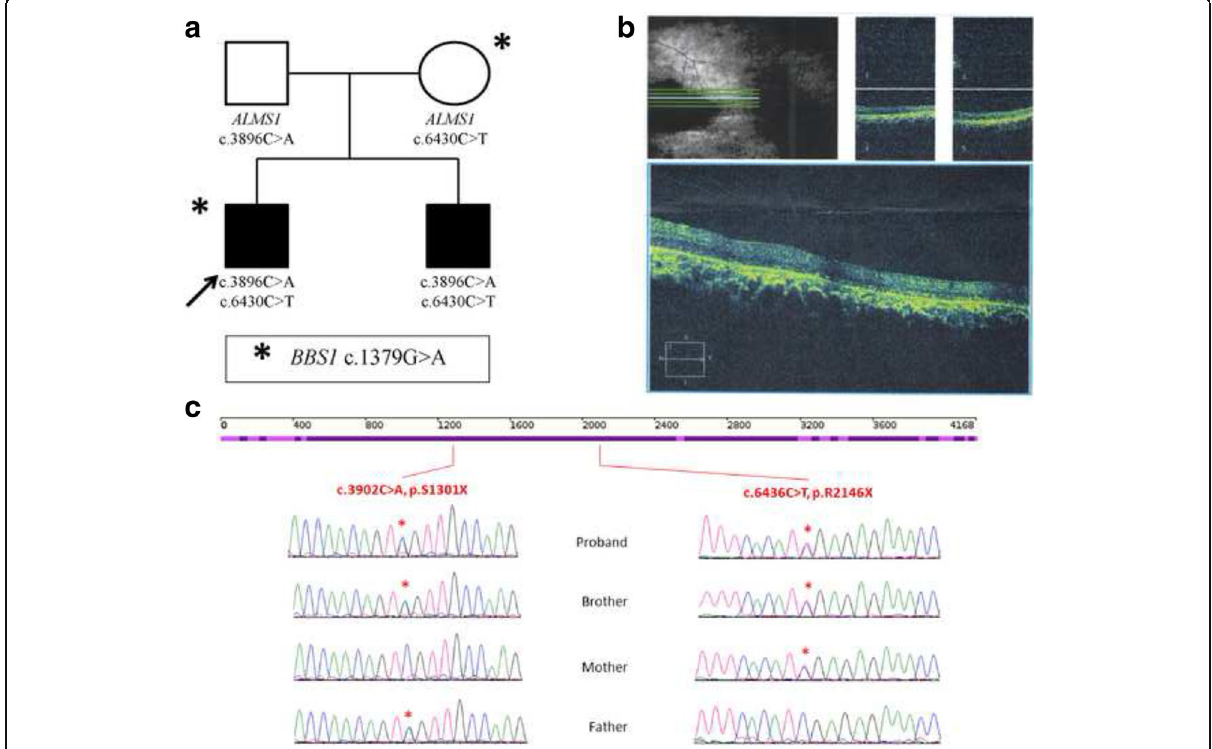
Fig. 1 Pedigrees of the family, Sanger sequencing confirmation and Optical coherence tomography of the proband. a Pedigrees of the quartet families. b Optical coherence tomography of the proband reveals atrophy of the retina with epiretinal membrane and retina pigment epithelium irregularly arrangement. c Sanger sequencing confirmation in the quartet family. Heterozygous nucleotide and amino acid substitutions are shown at the top. Presence of the mutated alleles is indicated by a red